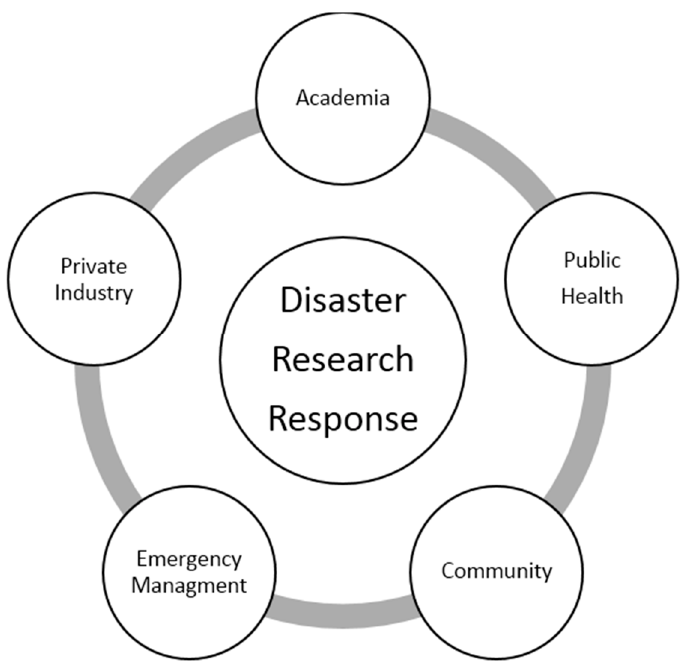
Figure 2. Disaster research partners.